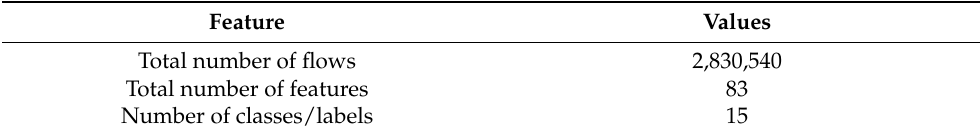
Table 1. Properties of the CICIDS2017 dataset.